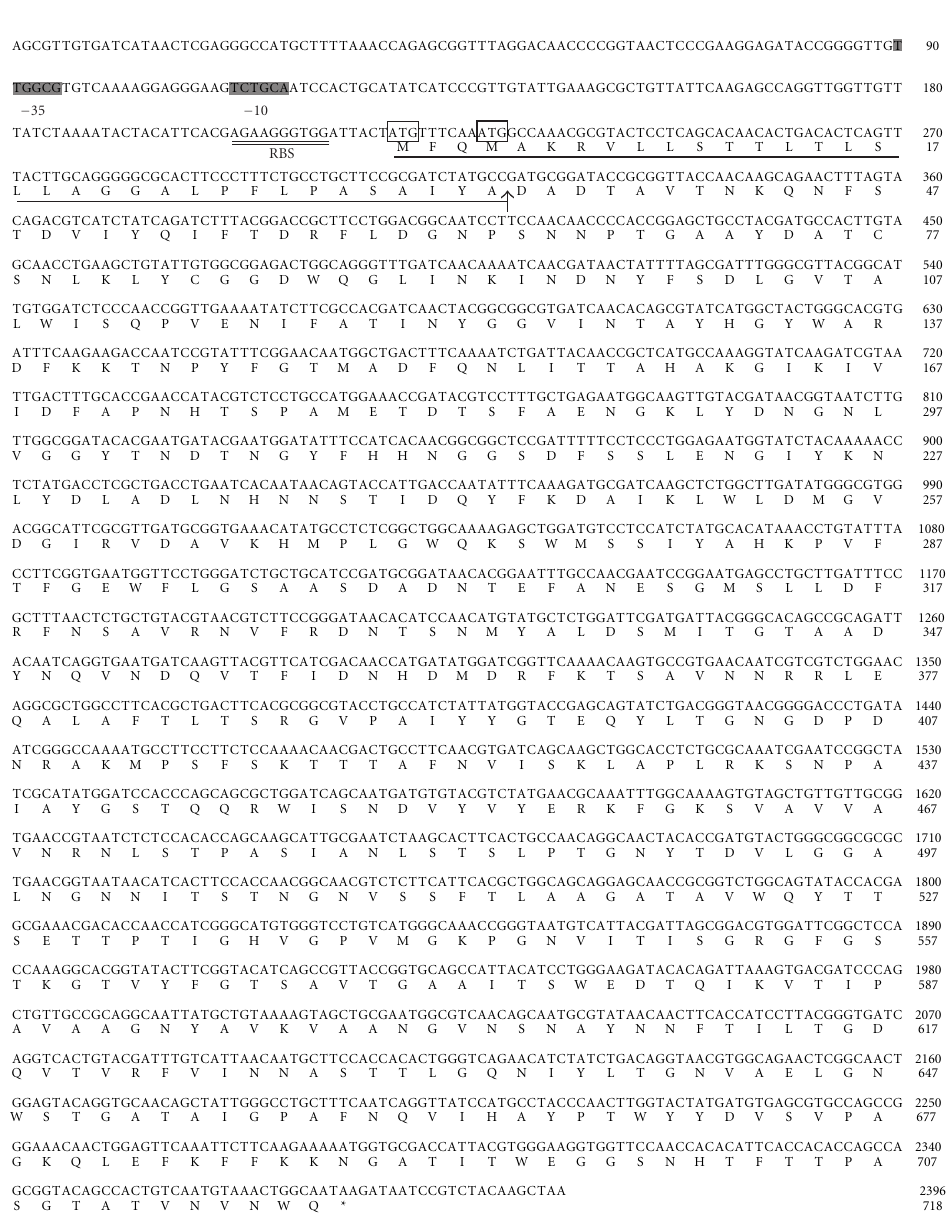
∗ HIC: Hydrophobic Interaction Chromatography.